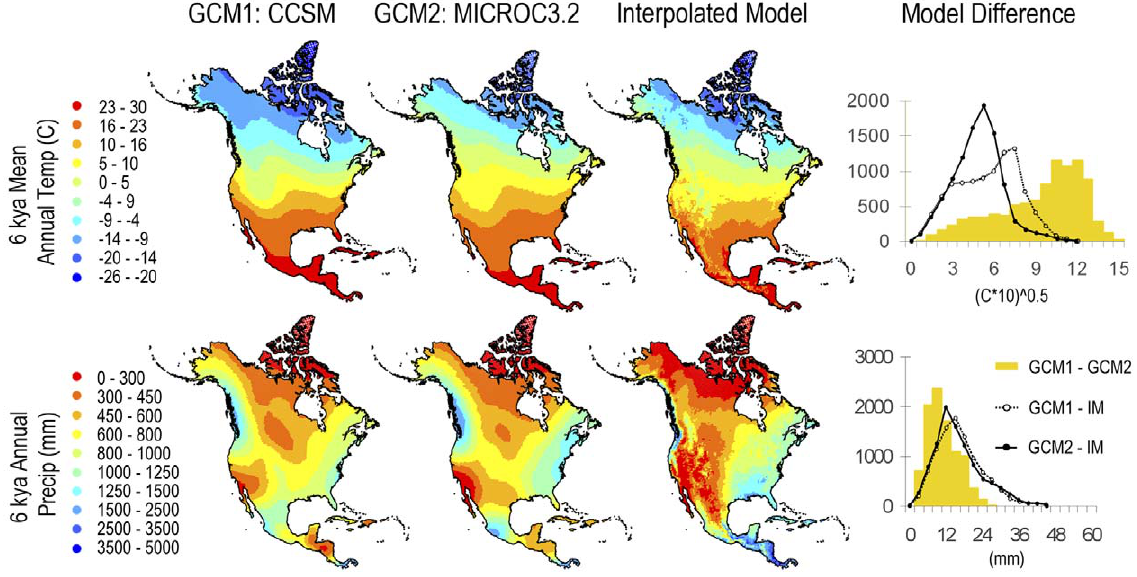
Figure 3. Mean annual temperature and annual precipitation modeled for 6 kya. Two general circulation models (GCM1 and 2) and our interpolation model (IM) are compared. Graphs at the right show histograms of the absolute differences between the two GCMs (yellow bars) and between our model and each of the GCMs (lines). doi:10.1371/journal.pone.0028554.g003 PLoS ONE |